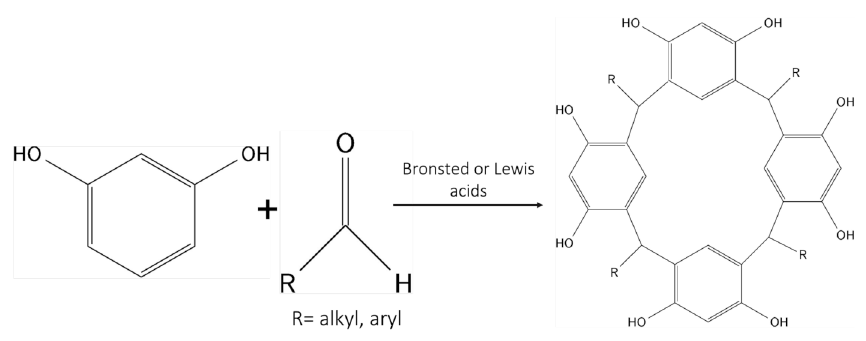
Figure 1. The condensation reaction between resorcinol and aldehyde.